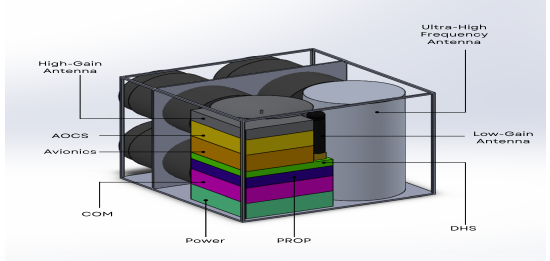
Figure 2. Deployment of the satellite system.